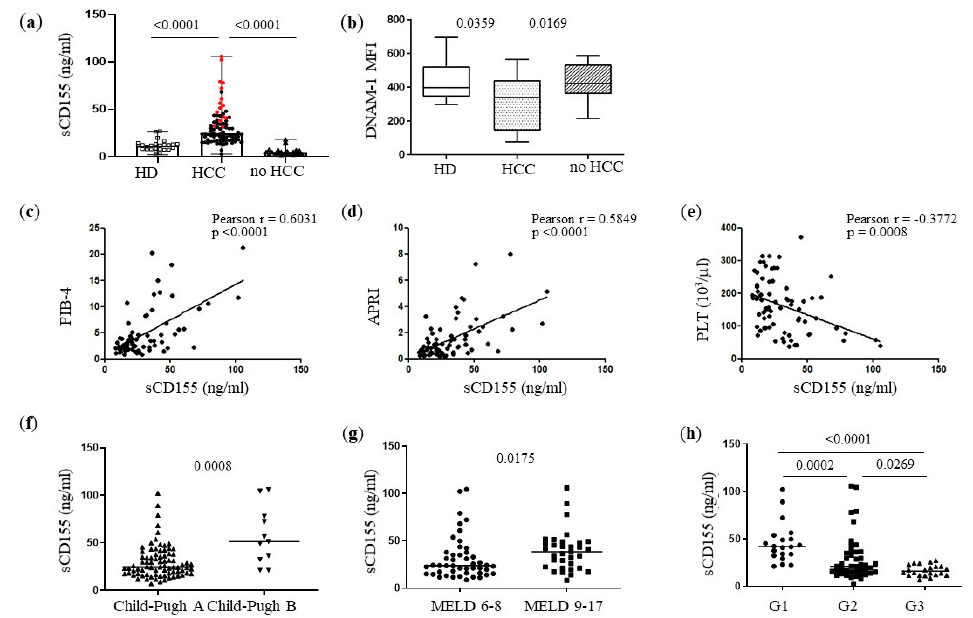
Figure 1. Soluble CD155 correlates with advanced disease in HCC patients. ( a ) Soluble CD155 (sCD155) was tested in sera of 30 HD, 88 HCC and 22 no HCC subjects. HCC patients with an advanced disease are indicated as red dots. ( b ) DNAM-1 expression (mean fluorescence intensity, MFI) in NK cells of 16 HDs, 30 HCC subjects, and 16 no HCC subjects. ( c – e ) Correlation between sCD155 concentration in serum form HCC patients and FIB-4, APRI and number of platelets (PLT). ( f , g ) sCD155 in HCC stratified according to Child–Pugh (A, n = 75; B n = 11) and MELD (6–8, n = 46; 9–17, n = 34) disease indicators. ( h ) sCD155 in HCC stratified according to the grade of tumor differentiation: G1, G2, and G3 (well, moderately and poorly differentiated, respectively); G1: n = 21; G2, n = 43; G3, n = 22. Middle bars represent median values, box plots are 25% and 75% percentiles, whiskers are minimum and maximum values. The non-parametric Kruskal–Wallis or Mann–Whitney U tests were used to compare data in ( a , b ) and ( f – h ) panels. The non-parametric Spearman’s test was used to correlate sCD155 and clinical parameters (( c – e ) panels).